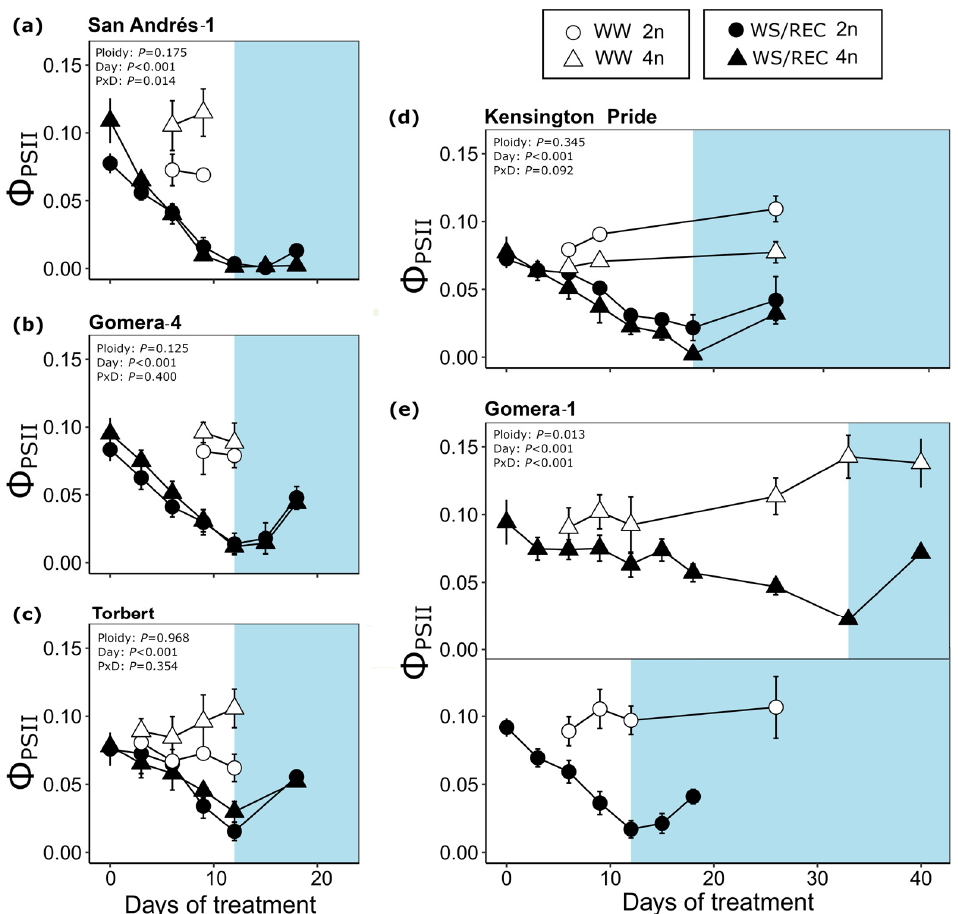
Figure 3. Dynamics of quantum photochemical yield of photosystem II ( Φ PSII ) measured at 1200 µ mol m − 2 s − 1 during drought (white background) and rewatering (blue) application in well-watered (WW, white symbols) and water-stressed (WS, black symbols) trees of the tetraploid (circles) and diploid (triangles) genotypes of the following cultivars: ( a ) ‘San Andrés-1’, ( b ) ‘Gomera-4’, ( c ) ‘Torbert’, ( d ) ‘Kensington Pride’, and ( e ) ‘Gomera-1’. Dynamics of diploid and tetraploid Gomera-1 plants are split in two subpanels within panel ( e ). The result of the mixed model for WS data (ex- cluding rewatering period) is shown in left upper corner of each panel. Values are means ± SE ( n = 5).